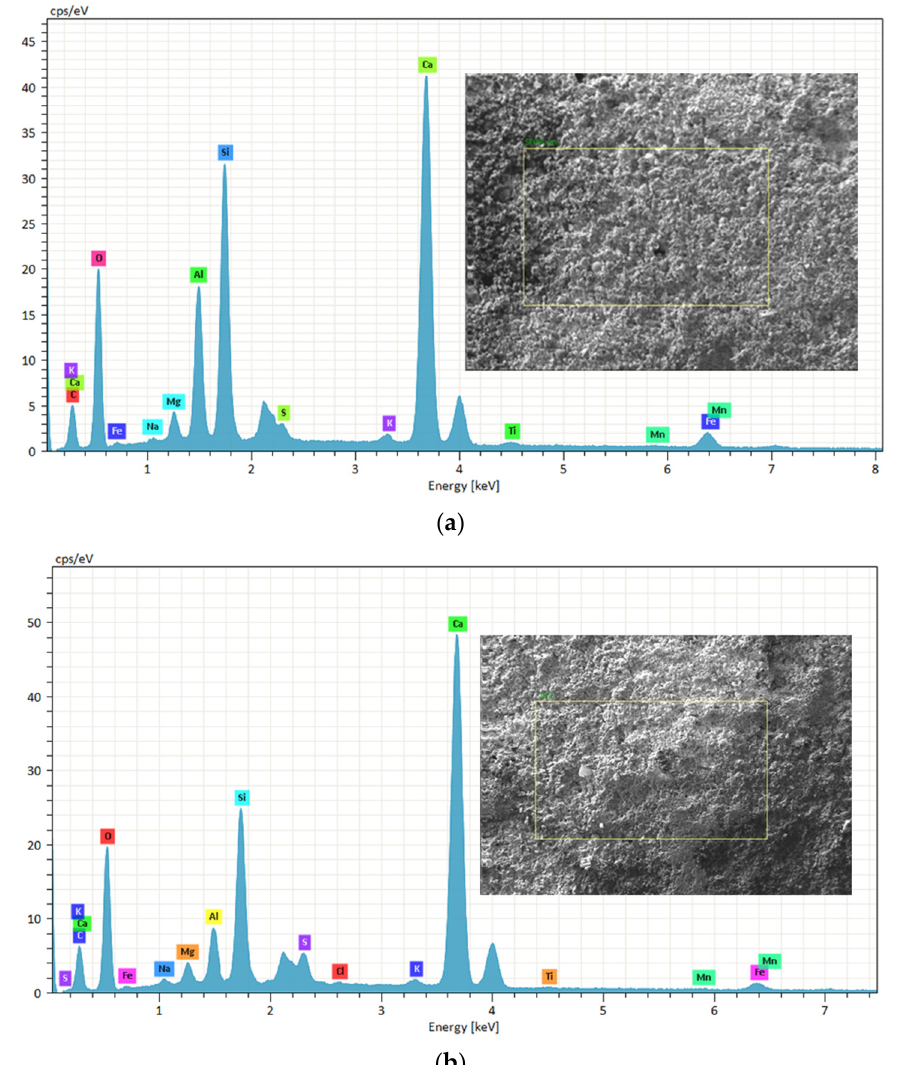
Figure 14. X-ray energy-spectrum analysis. ( a ) Group 3 experimental results of X-ray energy-spec- trum analysis. ( b ) Group 6 experimental results of X-ray energy-spectrum analysis.